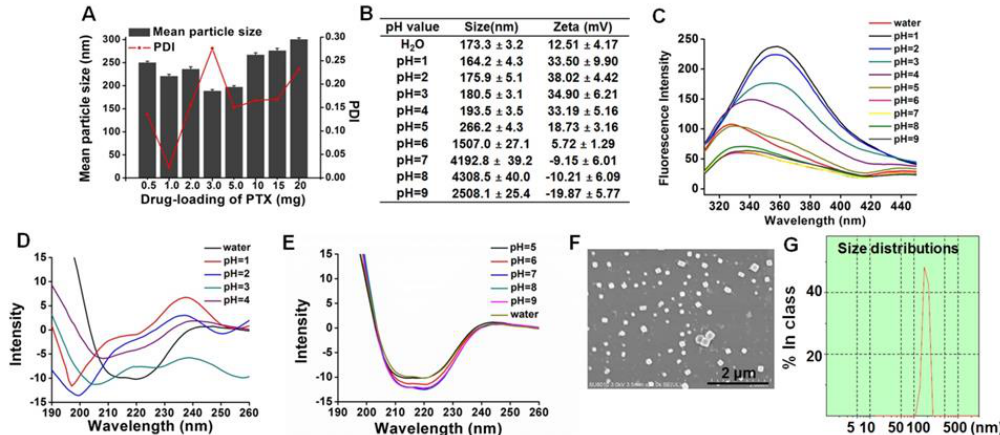
Figure 2. ( A ) The particle size with the drug loading of PTX from 0.5–20 mg. ( B ) Particle size and zeta potential of ANSs with the pH value ranging from 1–9. ( C ) The fluorescence emission spectrum of Hb with pH from 1–9. The far UV Circular Dichroism (CD) spectrum of Hb at pH ( D ) ranging from 1–4 or ( E ) ranging from 5–9. ( F ) The scanning electron microscopy (SEM) image and ( G ) size distribution of ANSs with 50% loading of PTX.